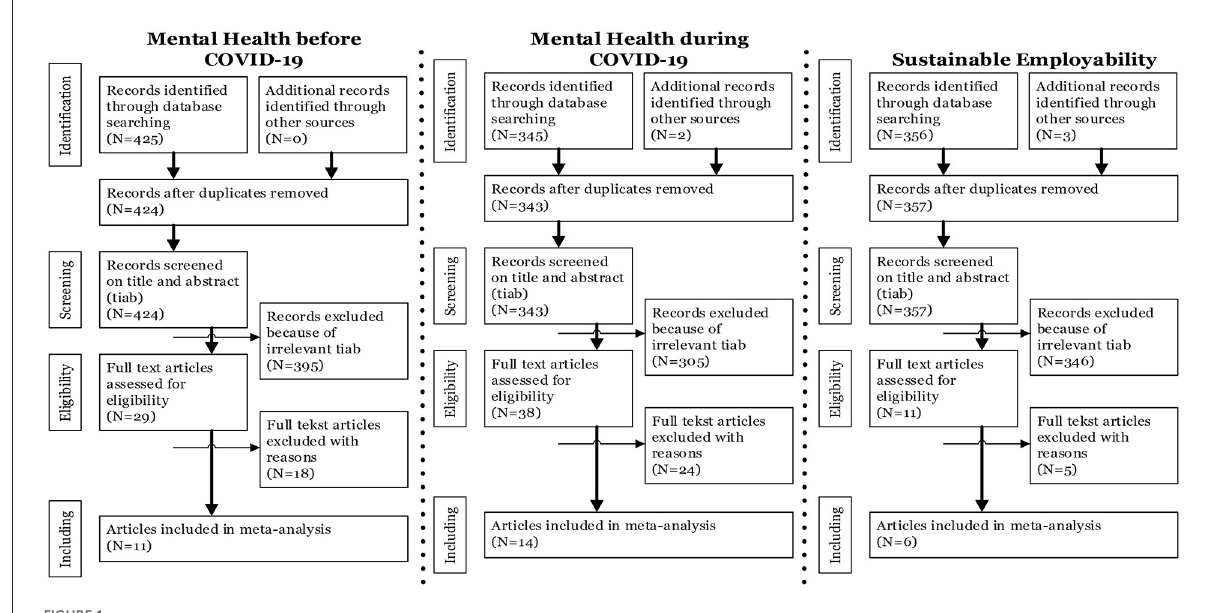
FIGURE1 PRISMA flowchart of citations